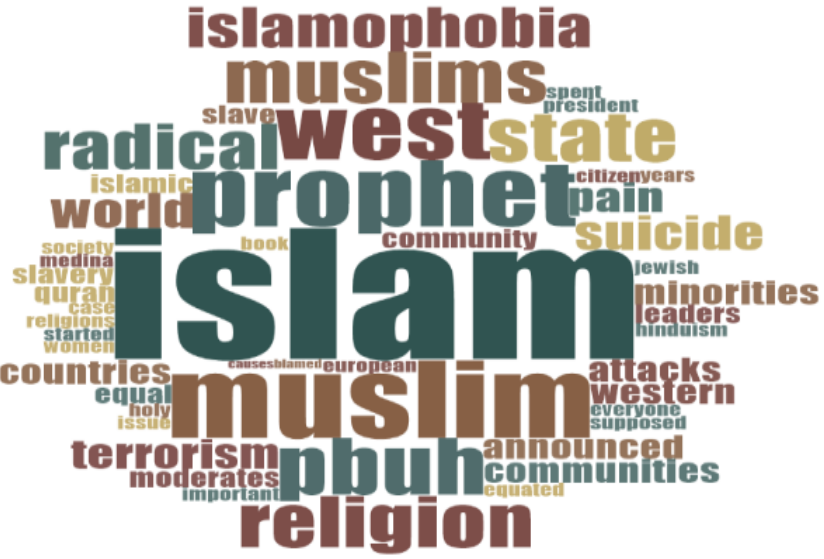
Figure 1. Word cloud of most-frequently used terms in the speech.